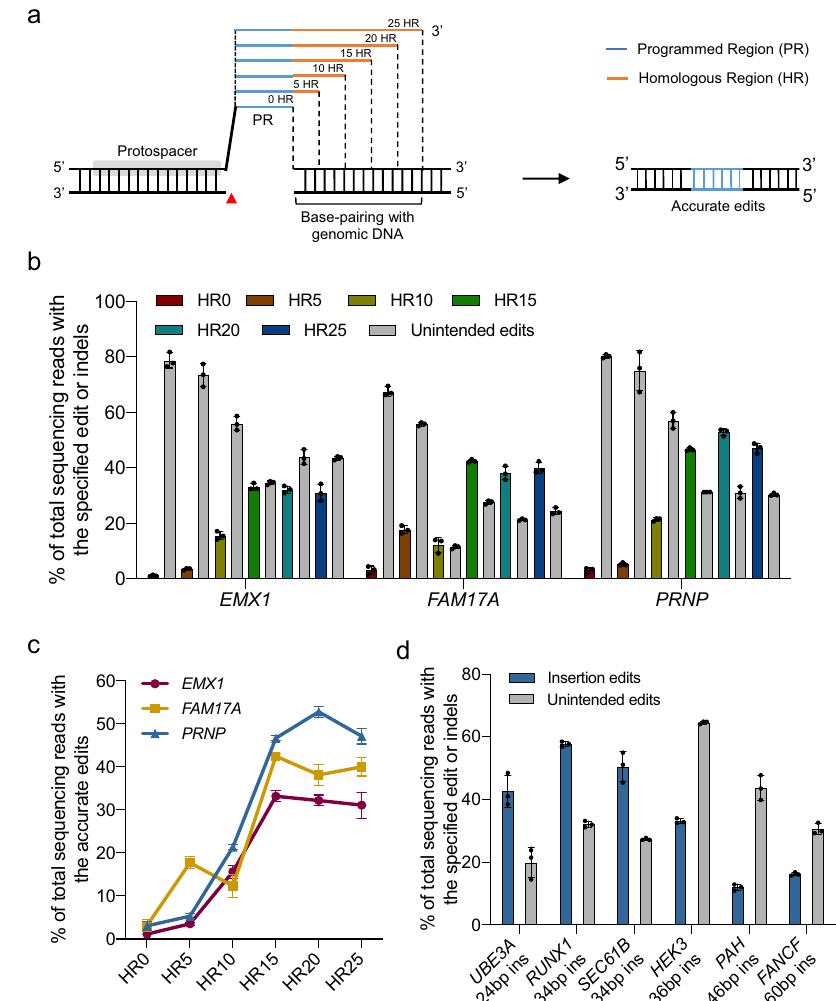
Fig. 2 | Impacts by the size of the homologous region in pegRNAs on uPEn- dependentediting.a Schematicsofhomologousregion-containingpegRNAs(HR- pegRNA) with different sizes of the HR (orange). PR, programmed region (blue). RedarrowindicatesthepositionofuPEn-inducedDSB. b uPEn(intheuPEn3format, same throughout this fi gure) editing ef fi ciencies ofusing pegRNAs with differently sized HR at EMX1 , FAM17A and PRNP sites in HEK293T cells. Values and error bars